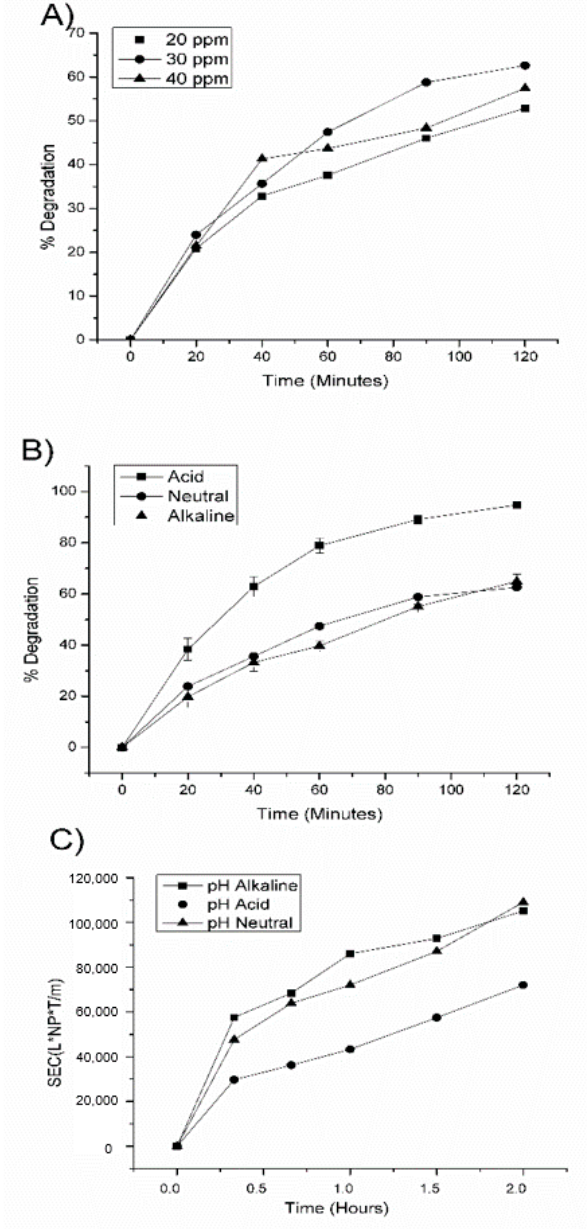
Figure 7. Percentage of nitrobenzene (NB) photodegradation by ZnO 2 nanoparticles at different ( A ) photocatalyst concentrations, ( B ) different initial pH value with 30 ppm of photocatalyst and ( C ) specific energy consumption for each reaction at different pH values.